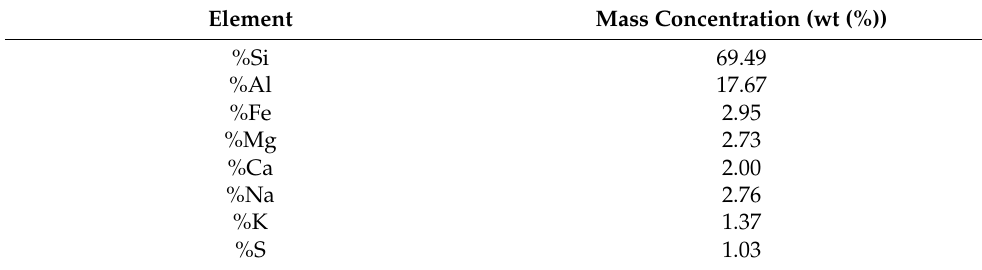
Table 3. Chemical composition of activated sodium bentonite (Na-Mt), by EDS/EDAX